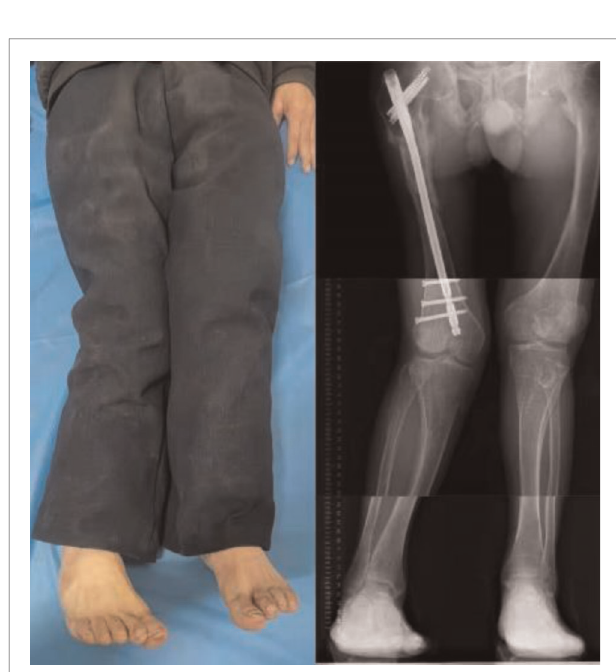
FIGURE 9 | At 14 months postoperatively, the fracture was completely